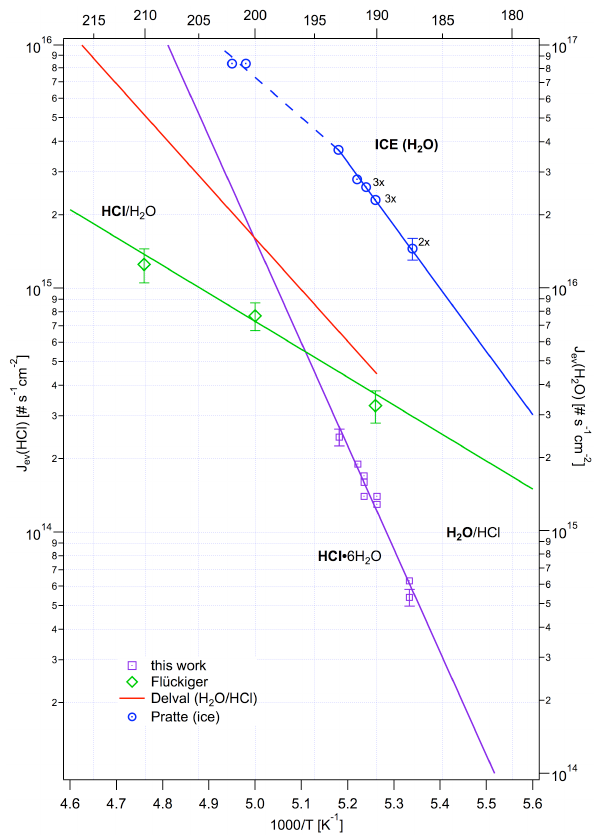
Fig. 7. HCl (left ordinate, bold HCl in plot) and H 2 O (right or- dinate, bold H 2 O in plot) evaporation rates as a function of 1/ T q Figure 7. HCl (left ordinate, bold HCl in plot) and H 2 O (right ordinate, bold H 2 O in plot) evaporation of HCl 6H 2 O (this work, decay monitored using FTIR absorp- q rates as a function of 1/T of: HCl •6H 2 O (this work, decay monitored using FTIR absorption of tion of HCl 6H 2 O, purple line), HCl–H 2 O (Flückiger et al., 1998; green line), H 2 O/HCl (Delval et al., 2003; red line) and pure HCl•6H 2 O, purple line), HCl /H 2 O (Flückiger et al., 1998, green line), H 2 O /HCl (Delval et al., 2003, H 2 O ice (Pratte et al., 2006; blue line). The green and purple red line) and pure H 2 O ice (Pratte et al., 2006, blue line). The green and purple lines correspond to lines correspond to log J ev (HCl)/moleccm − 2 s − 1 = (20.6 ± 2.1) − logJ ev (HCl)/molec cm -2 s -1 = (20.6 ± 2.1) – (21967 ± 4800)/2.303RT, and logJ ev (HH)/molec cm -2 s -1 = (21967 ± 4800)/2.303 RT , and logJ ev (HH)/molec cm − 2 s − 1 = (36.34 ± 3.20) – (80810 ± 5800)/2.303RT, R = 8.314 J/K mol, respectively. (36.34 ± 3.20) – (80810 ± 5800)/2.303 RT , R = 8.314JK − 1 mol,